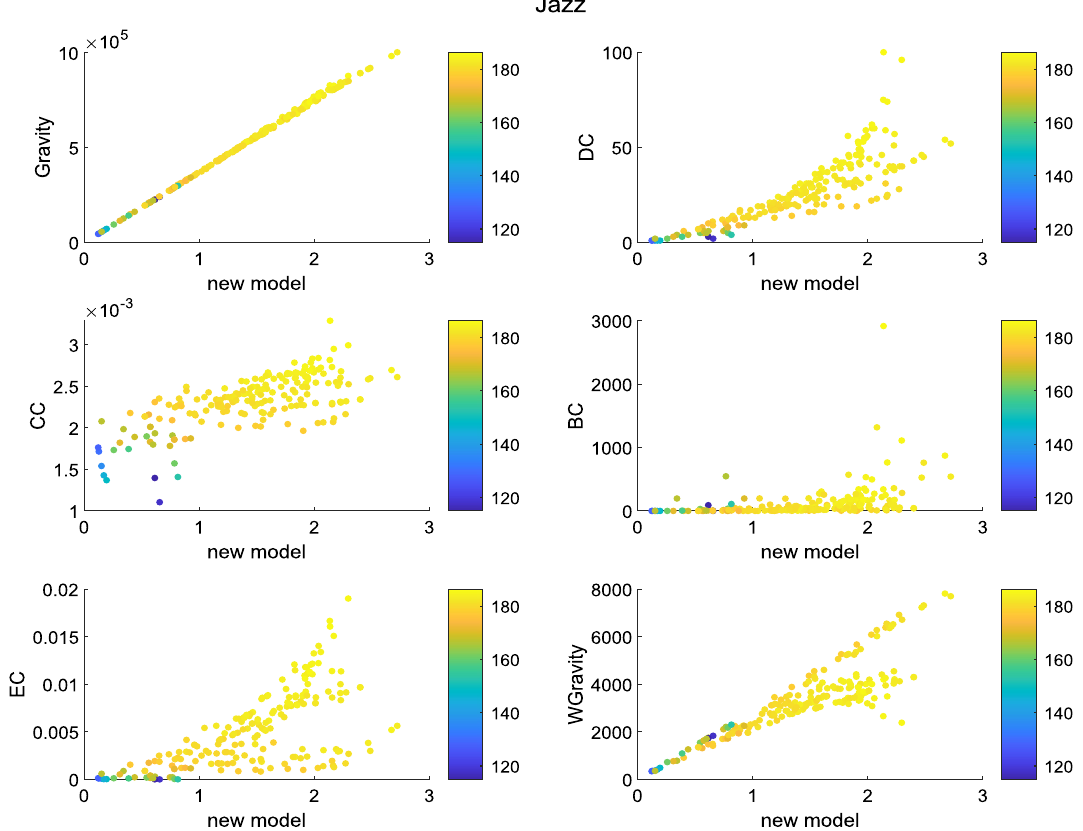
Figure 9. The figure describes the correlation between the new model and other methods in Jazz. The new model has a strong positive correlation with Gravity model. The liner relation with DC, EC and weighted gravity model is also